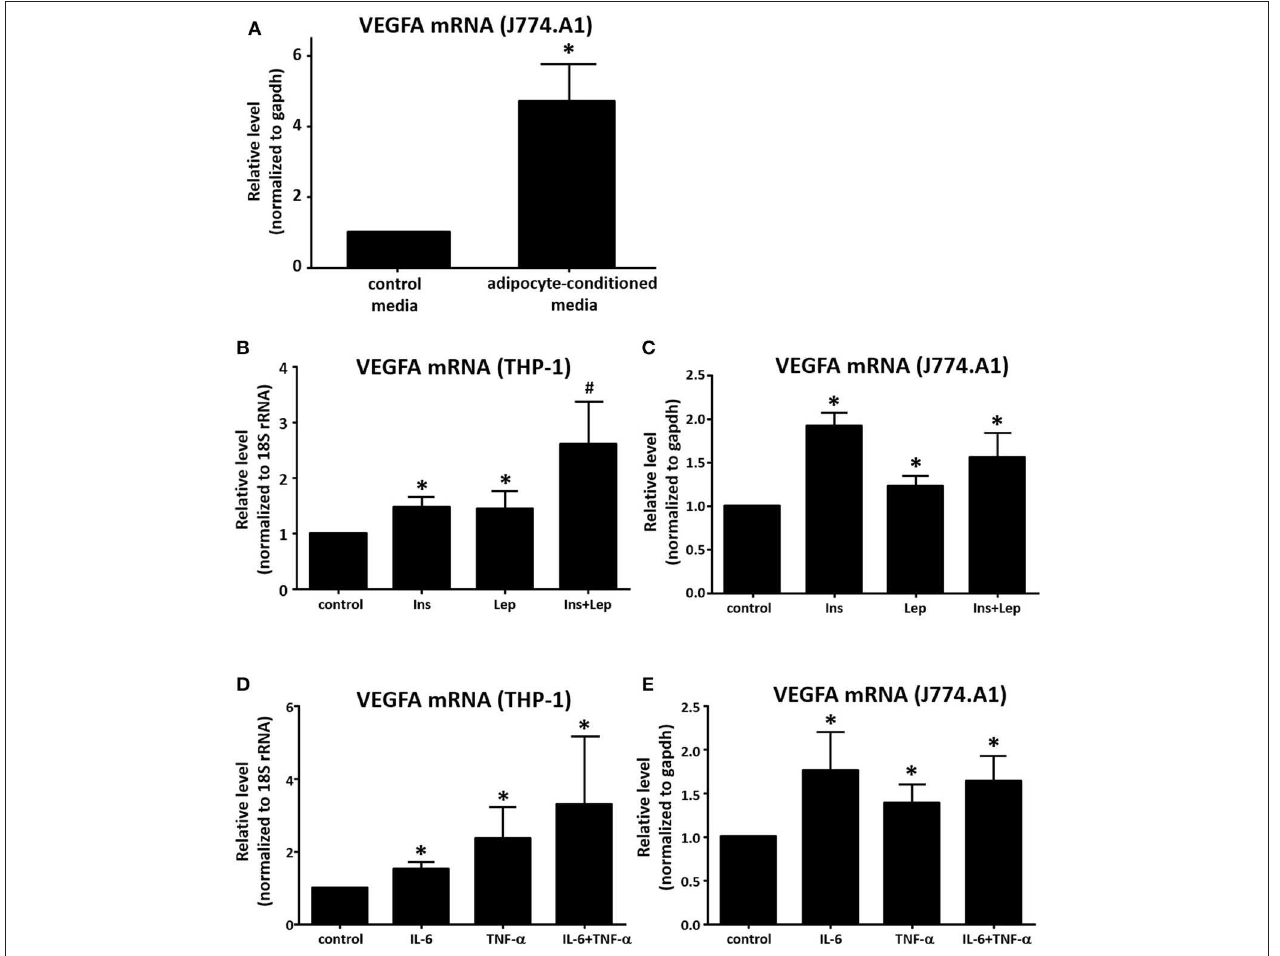
FIGURE 4 | Determination of effects of adipocyte mediators on macrophage VEGF expression. (A) Murine 3T3-L1 were differentiated for 12 days, media was changed to fresh DMEM + insulin and cells were allowed to incubate for an additional 48h. Media was then collected and placed onto murine J774A.1 macrophages plated 24h prior. After 8h of treatment with the adipocyte-conditioned media [or fresh DMEM + insulin (non-conditioned) as a control] RNA was collected, reverse transcribed and analyzed for transcriptional changes via qPCR using GAPDH and VEGFA primers ( n = 3, * p < 0.05). (B) PMA-differentiated THP-1 macrophages were treated for 8h with insulin (500nM), leptin (1 µ g/mL), or insulin (500nM) + leptin (1 µ g/mL), then RNA was collected and analyzed by qPCR ( n = 4, * p < 0.05) statistical analyses were performed using standard deviation and the unpaired Student’s t -test. (C) J774A.1 macrophages were treated for 8h with insulin (500nM), leptin (1 µ g/mL), or insulin (500nM) + leptin (1 µ g/mL), then RNA was collected and analyzed by qPCR ( n = 3, * p < 0.05); statistical analyses were performed using standard deviation and the unpaired Student’s t -test. (D) PMA-differentiated THP-1 macrophages were treated for 8h with IL-6 (10ng/mL), TNF- α (10ng/mL), or IL-6 (10ng/mL) + TNF- α (10ng/mL), then RNA was collected and analyzed by qPCR ( n = 4, * p < 0.05); statistical analyses were performed using standard deviation and the unpaired Student’s t -test. (E) J774A.1 macrophages were treated for 8h with IL-6 (10ng/mL), TNF- α (10ng/mL), or IL-6 (10ng/mL) + TNF- α (10ng/mL), then RNA was collected and analyzed by qPCR ( n = 3, * p < 0.05); statistical analyses were performed using standard deviation and the unpaired Student’s t